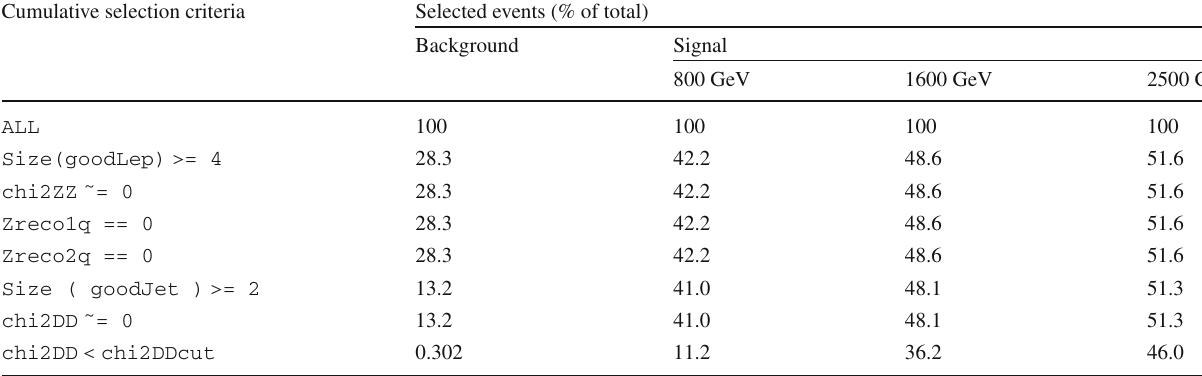
Table 3 Percentage selection efficiencies for various signals and background for the FCC-hh selection Cumulative selection criteria Selected events (% of